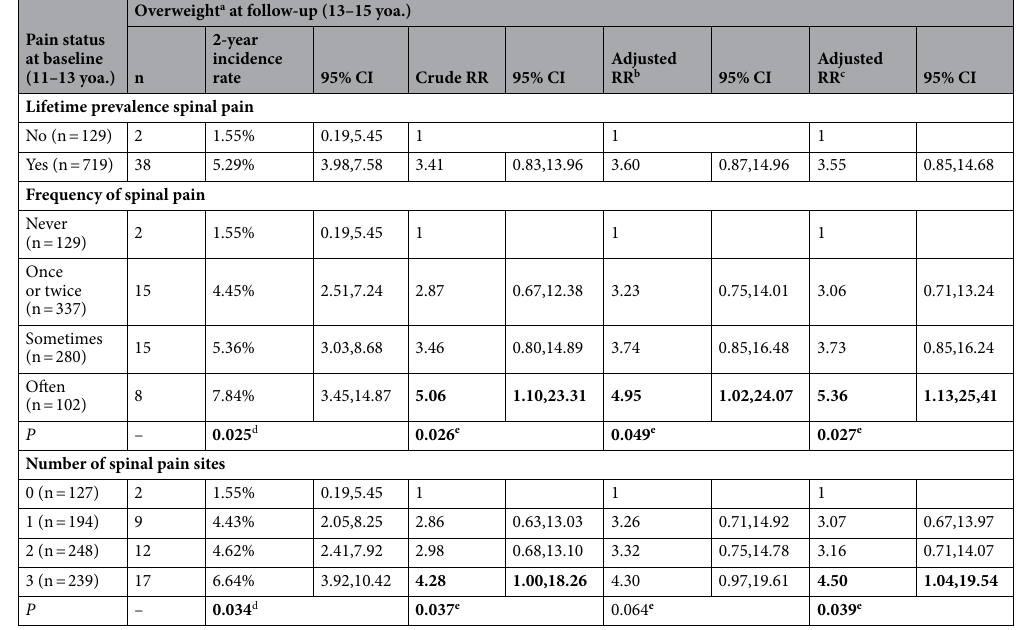
Table 2. The relationship between spinal pain at age 11–13 and overweight at age 13–15 in a school-based cohort with 848 normal-weight Danes (2010–2012) reporting both the theory driven and the data-driven models. Bold font indicates statistical significance. CI confidence intervals, RR relative risk. a Overweight is calculated by age and gender specific cut-points of Body Mass Index (BMI). b Theory-driven model adjusted for sex, age, social class and psychological health, n = 796. c Data-driven model adjusted for sex, psychological health and diet, n = 843. d Based on an extension of the Wilcoxon rank-sum test as defined by Cuzick. e Overall p-value for the